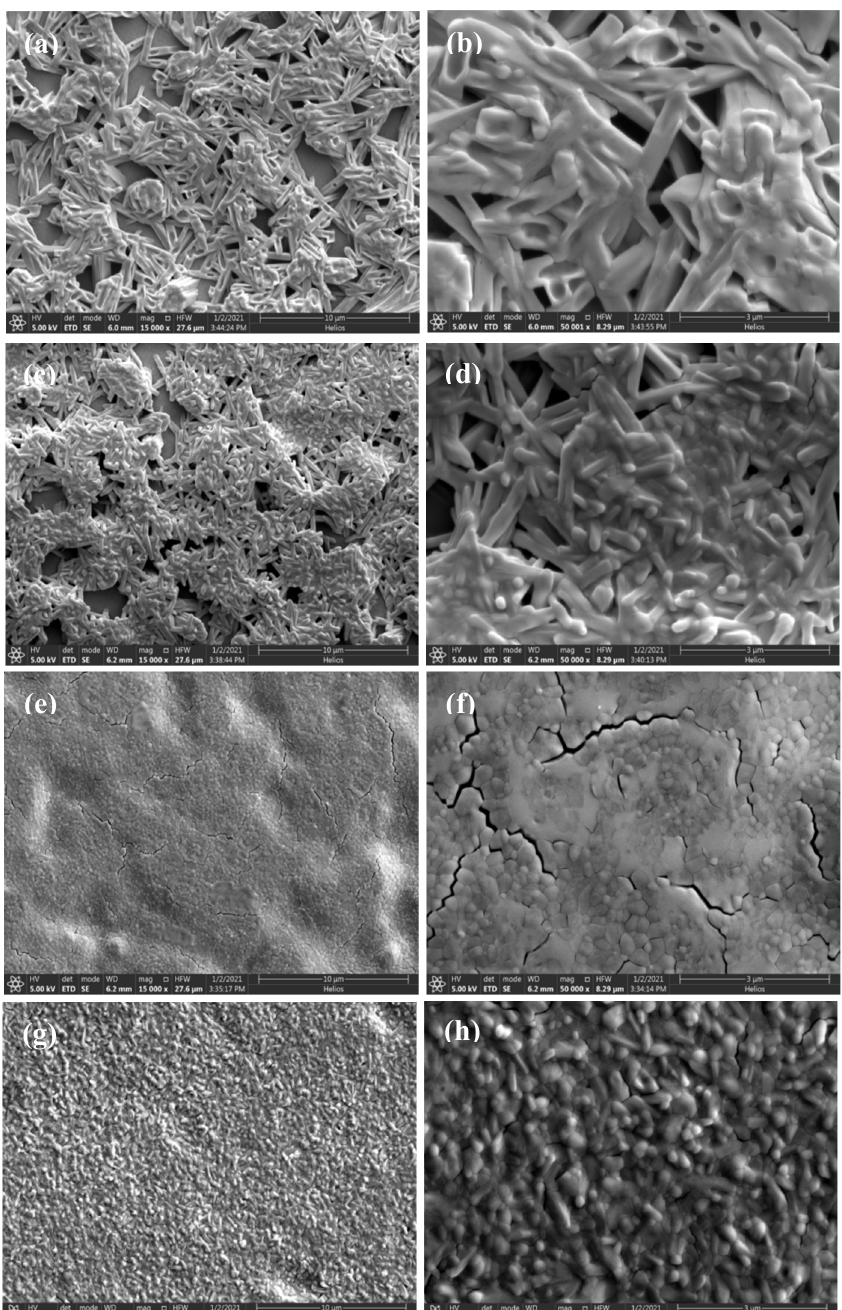
Figure 3. SEM top view of organic–inorganic hybrid ferroelectric thin films formed by different chlorobenzene drops. ( a , b ) 100 μ L, ( c , d )80 μ L, ( e , f ) 60 μ L, and ( g , h ) 40 μ L. Table 1. Performance parameters of unpolarized devices before and after optimization.